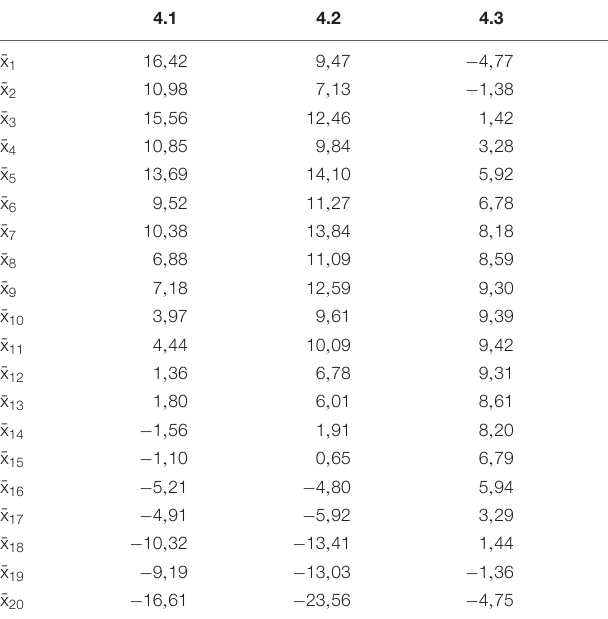
TABLE 4 | Optimal pretension factors corresponding to the TBMDs in Figure 9